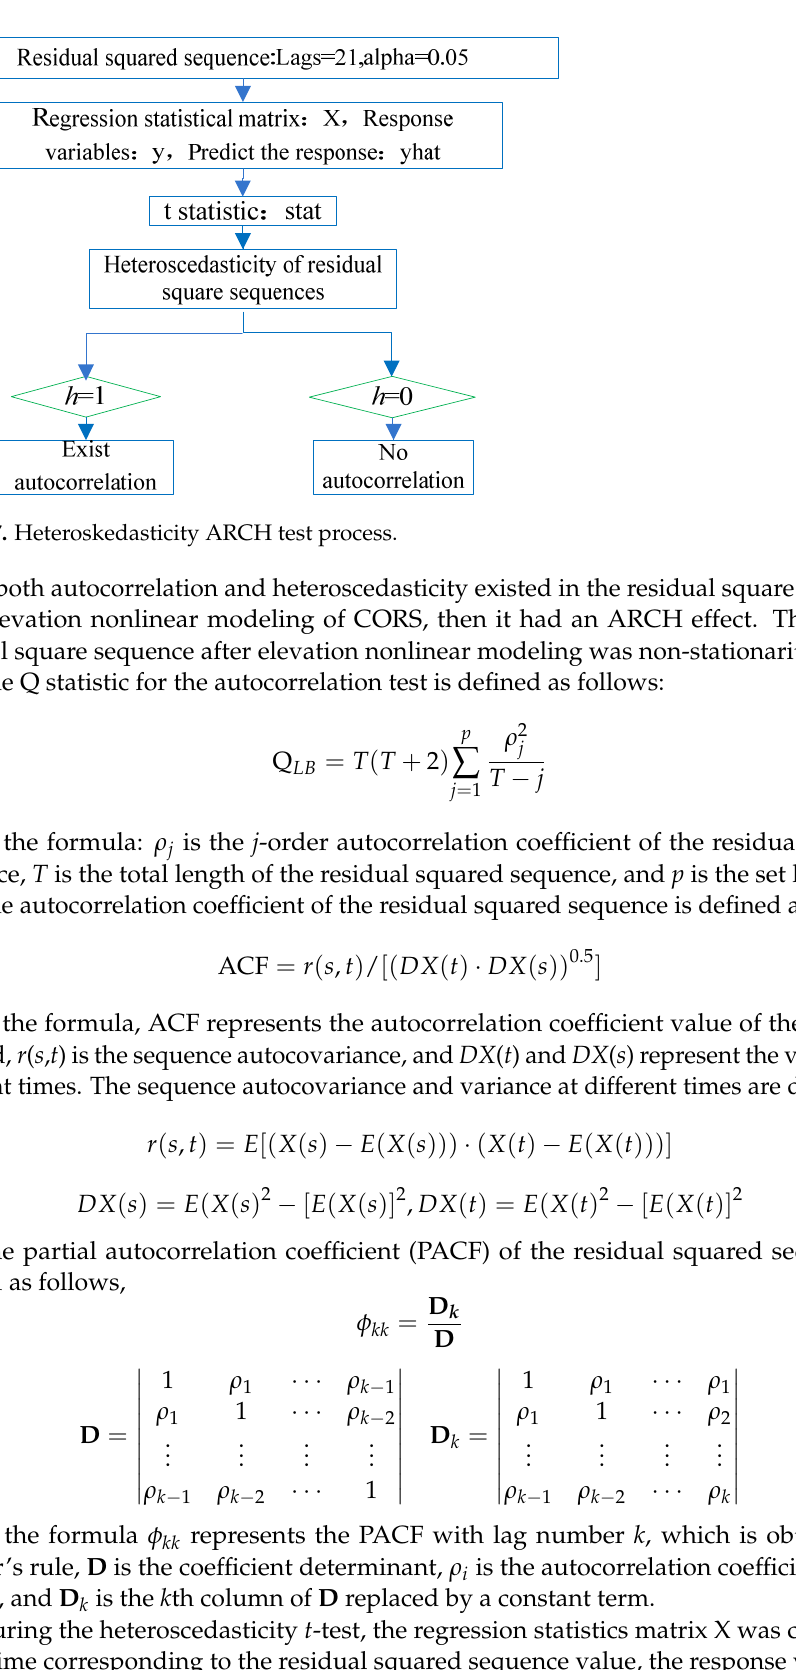
Figure 6. Autocorrelation Q test process.